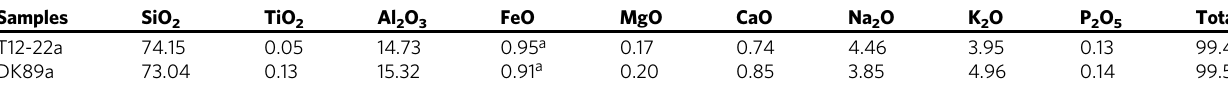
Table 1 Chemical compositions (given in wt%) of the leucogranitic rocks (T12-22a and DK89a) Samples SiO 2